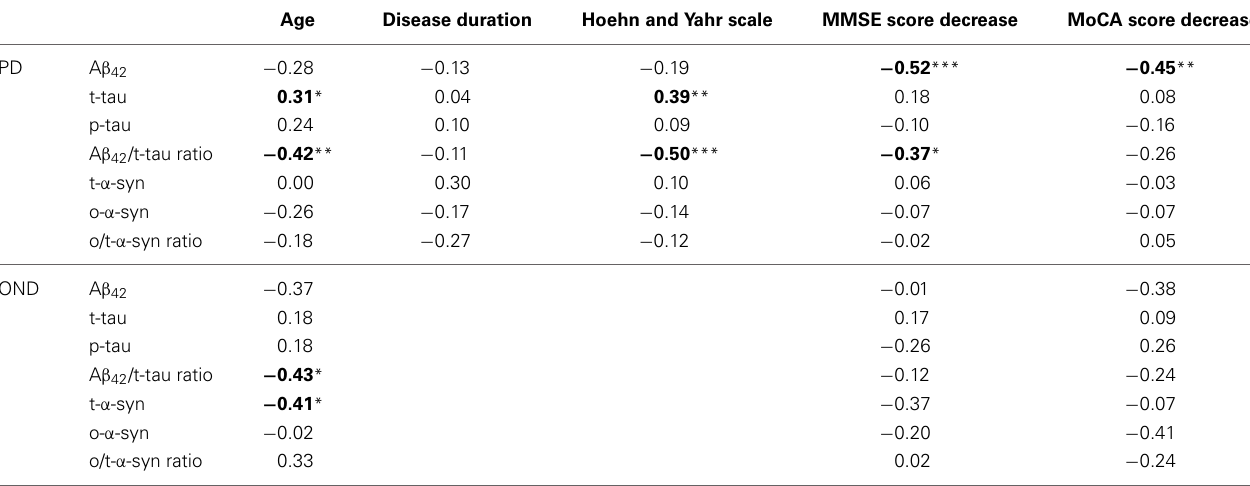
Table 4 | Spearman’s rank correlations between CSF biomarkers, age, disease duration, and clinical scores in PD group. Age Disease duration Hoehn and Yahr scale MMSE score decrease MoCA score decrease